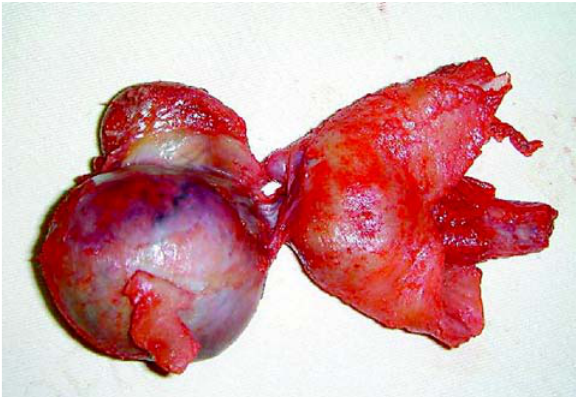
Figure 2 – Torsion in the epididymis corpus, leaving the head in